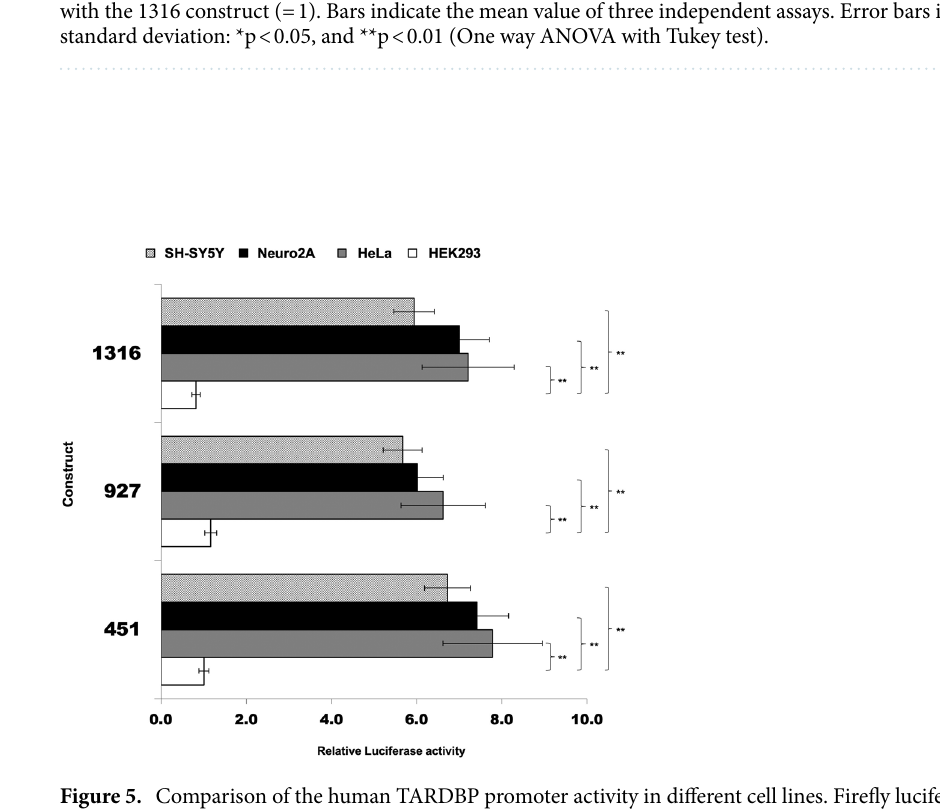
Figure 5. Comparison of the human TARDBP promoter activity in different cell lines. Firefly luciferase activity of 1316, 927 and 451 constructs was tested (normalized against Renilla) in different cell lines (HEK293, HeLa, SH-SY5Y and Neuro2A). Activity is expressed as-fold against transfections in HEK293 cells (= 1). Data are mean (± SD) of three independent assays: *p < 0.05, and **p < 0.01 (One way ANOVA with Tukey